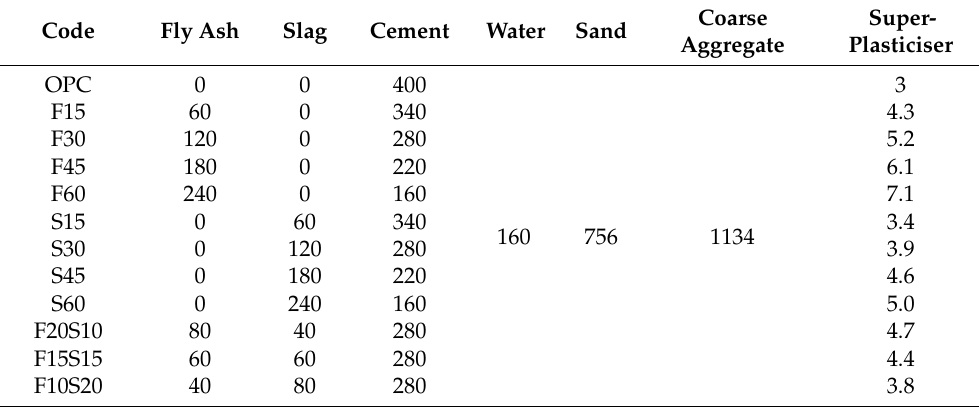
Table 2. Proportions of the different mixtures (kg/m 3 ).